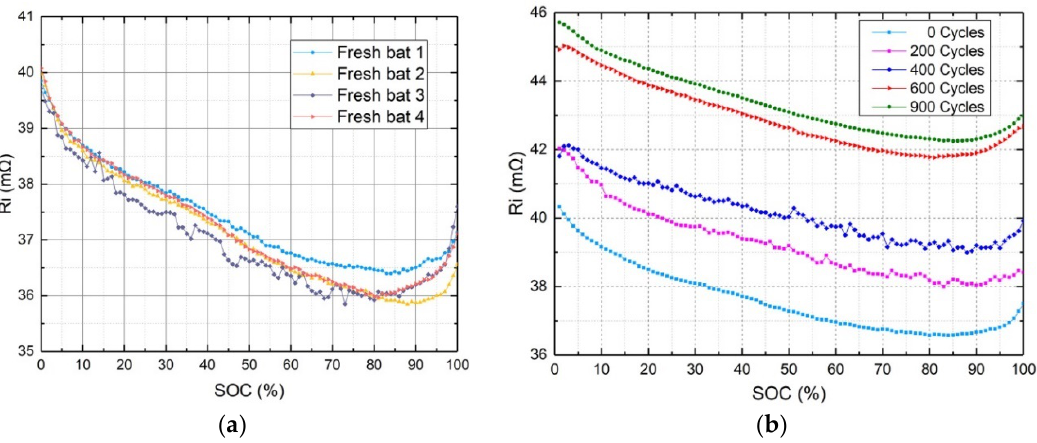
Figure 3. ( a ) Ri -SOC curves for different new batteries; ( b ) Ri -SOC curves for differently cycled batteries. Further, the internal resistance of different aging battery samples was detected by this method.